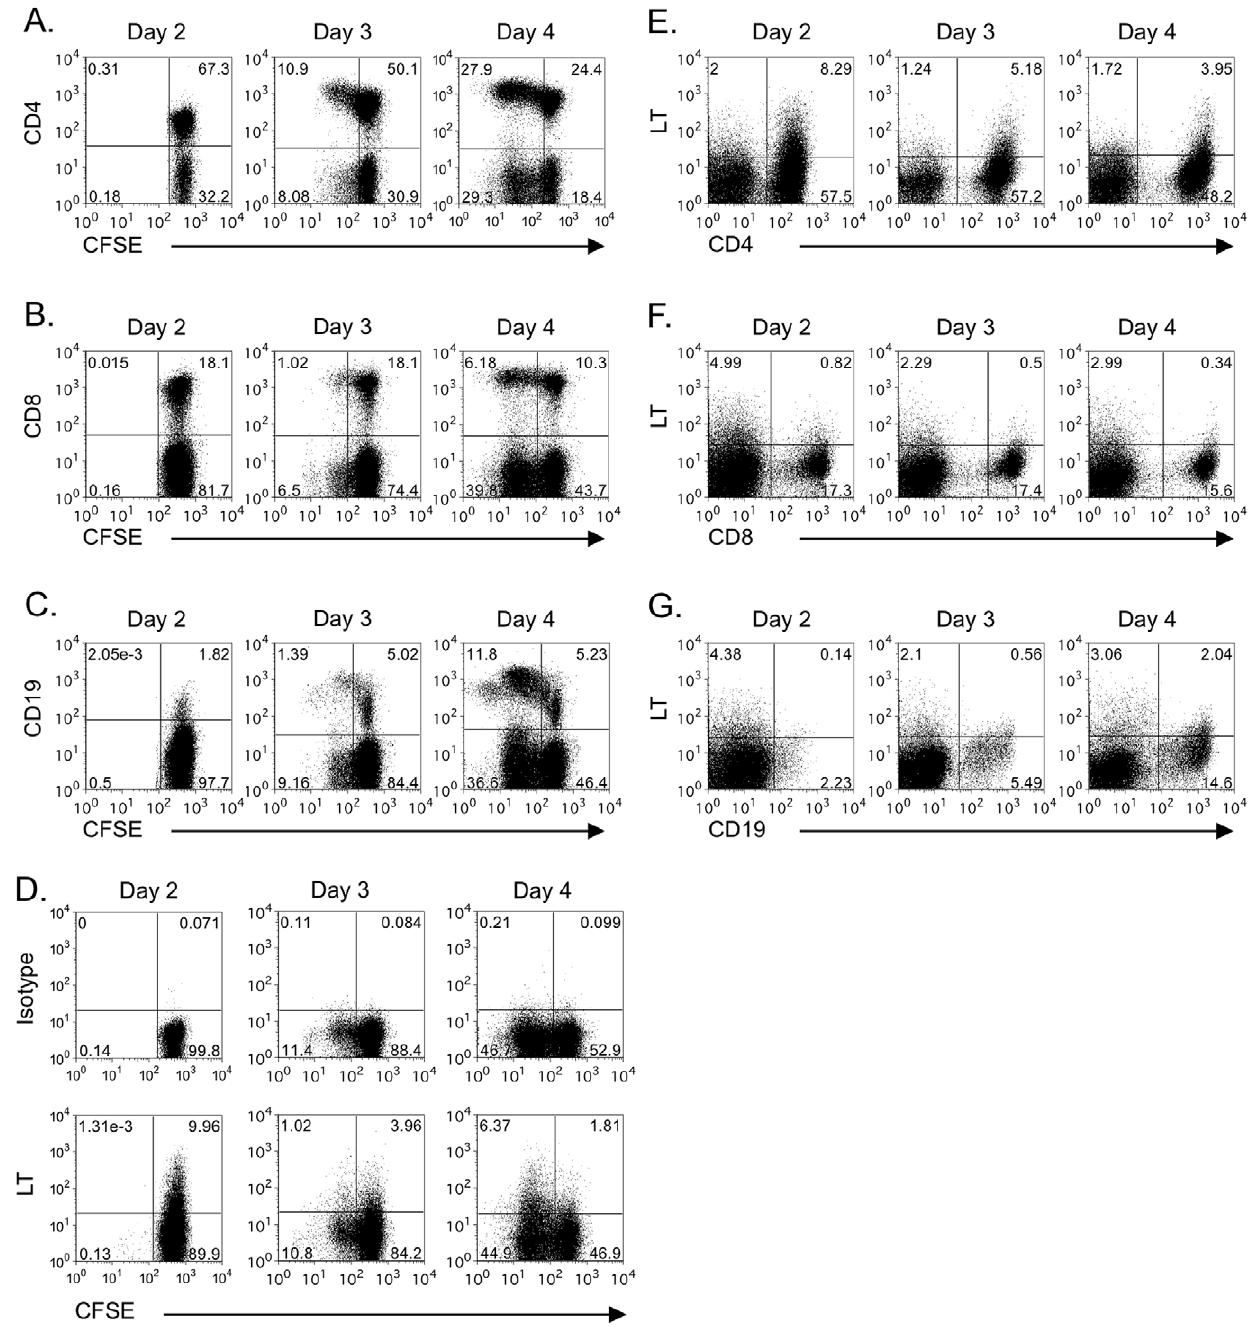
Figure 2. Expansion and expression of surface LT on human lymphocytes following transfer into SCID animals. CFSE-labeled human PBMCs were transferred into SCID mice via intrasplenic injection, then proliferation ( A–C ) or surface LT expression ( D–G ) was determined by flow cytometry. At indicated time points after transfer, spleen cells were harvested and human lymphocyte populations were identified on the basis of CFSE and specific cell marker staining. Proliferation of CD4 + T cells ( A ), CD8 + T cells ( B ) and CD19 + B cells ( C ). Surface LT expression on CFSE-labeled bulk transferred human PBMCs ( D ), or CFSE + gated CD4 + T cells ( E ), CD8 + T cells ( F ) and CD19 + B cells ( G ). In each experiment, 2–3 spleens were pooled to provide sufficient cell numbers for data collection. Data are representative of staining for 1 pool out of 3 per experiment. A minimum of 3 experiments were performed for each cell type. doi:10.1371/journal.pone.0033106.g002 CD4 + and CD8 + T cells maintained surface LT- a expression while surface LT- a was upregulated on B cells (Figure 2E–G, Figure S1). Overall, human PBMCs express surface LT- a soon after transfer and activation in SCID mice.